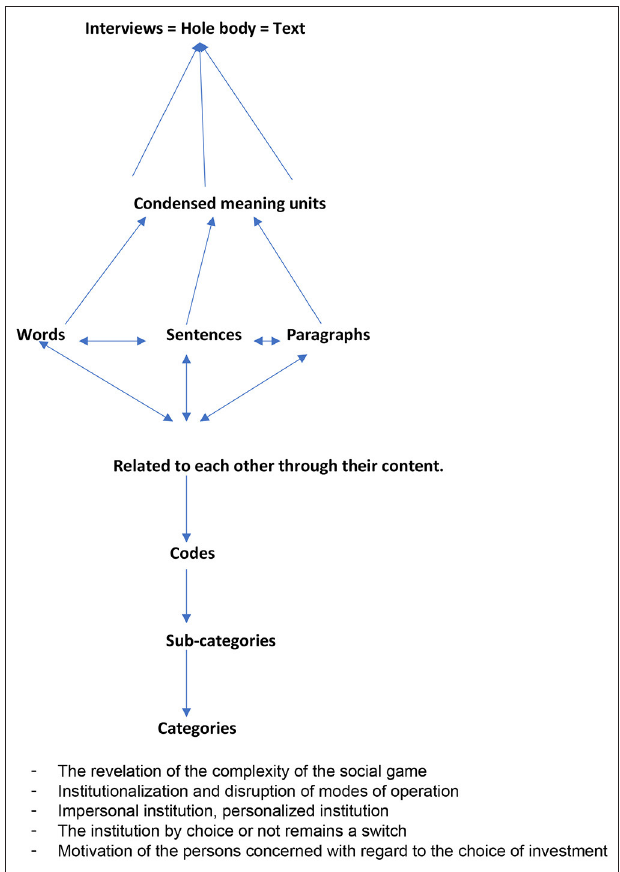
FIGURE 2 | Thematic analysis; from interviews to